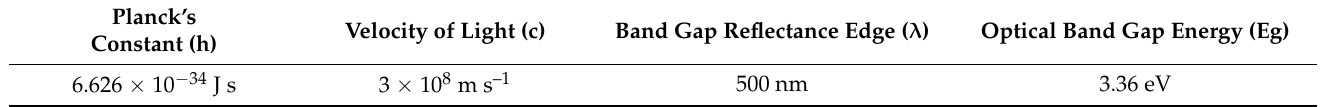
Figure 4. DRS spectrum ( a ) Tauc plot ( b ) for SnO 2 nanoparticles. Figure 4 . DRS spectrum ( a ) Tauc plot ( b ) for SnO 2 nanoparticles . Table 2. Optical band gap energy of SnO 2